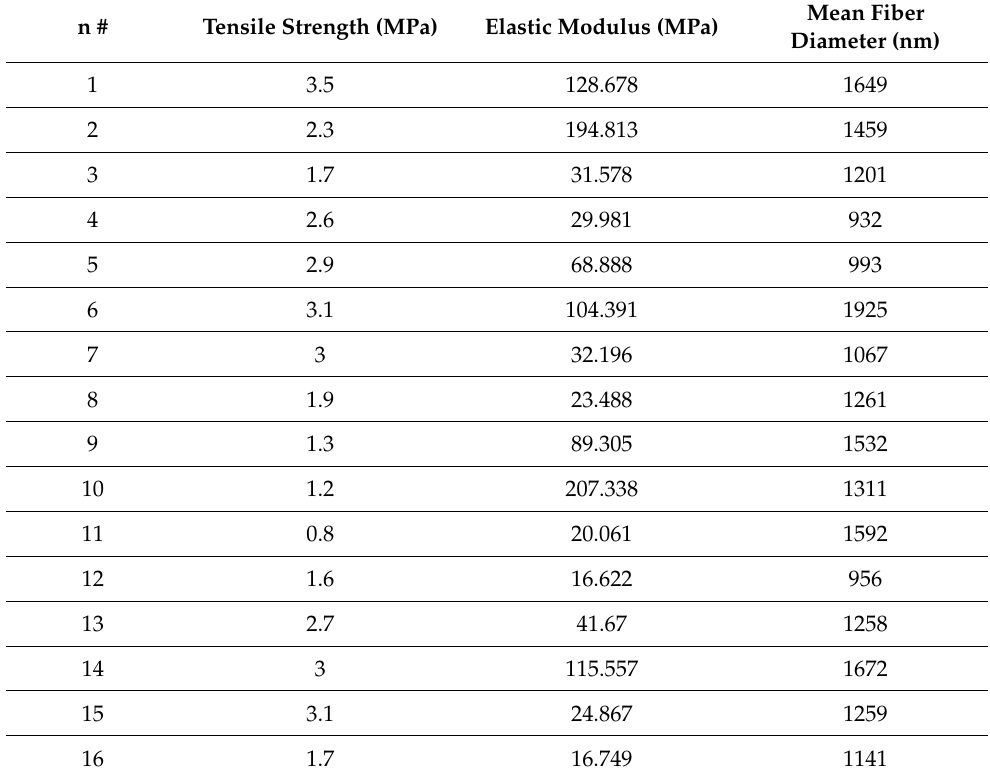
Table 1. TS, modulus, and MFD values for all 16